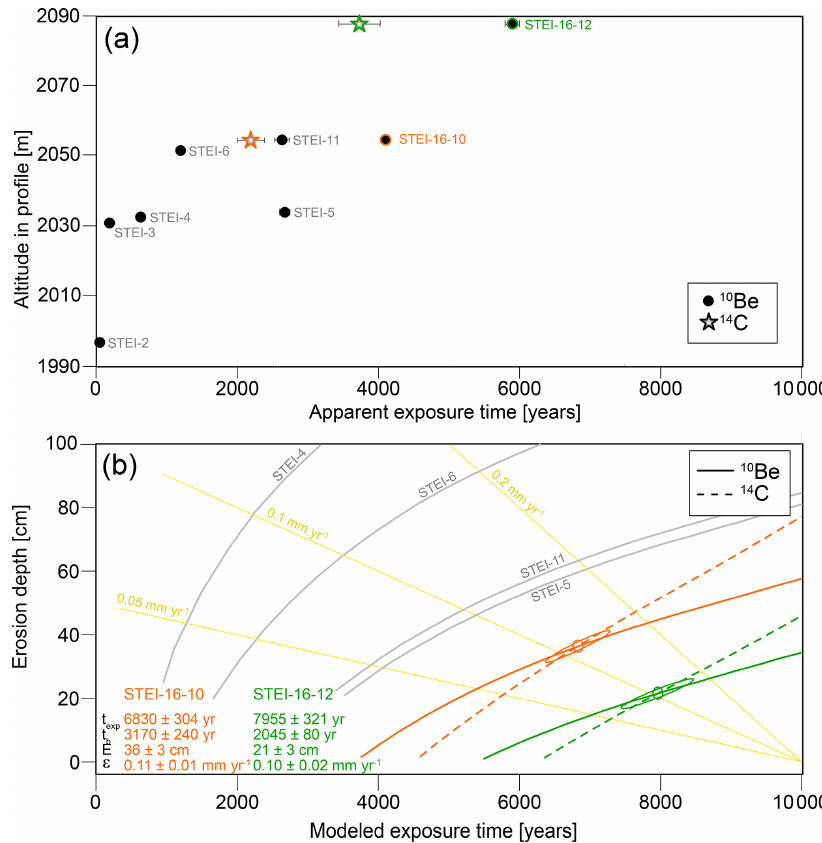
Figure 6. Exposure durations of bedrock samples inferred from measured in situ 10 Be and 14 C concentrations. (a) Apparent exposure durations calculated from 10 Be concentrations of eight samples and 14 C concentrations of two samples as a function of position in the glacial trough profile. The subglacial erosion effect during ice burial is not accounted for; calculations therefore yield minimum exposure durations. (b) Exposure durations and erosion depths modeled from combined in situ 10 Be and 14 C concentrations of samples STEI-16-10 and -12 (orange and green signatures). Solid grey curves represent possible exposure duration and erosion–depth combinations for samples with 10 Be concentration only. Yellow lines indicate selected theoretical bedrock erosion